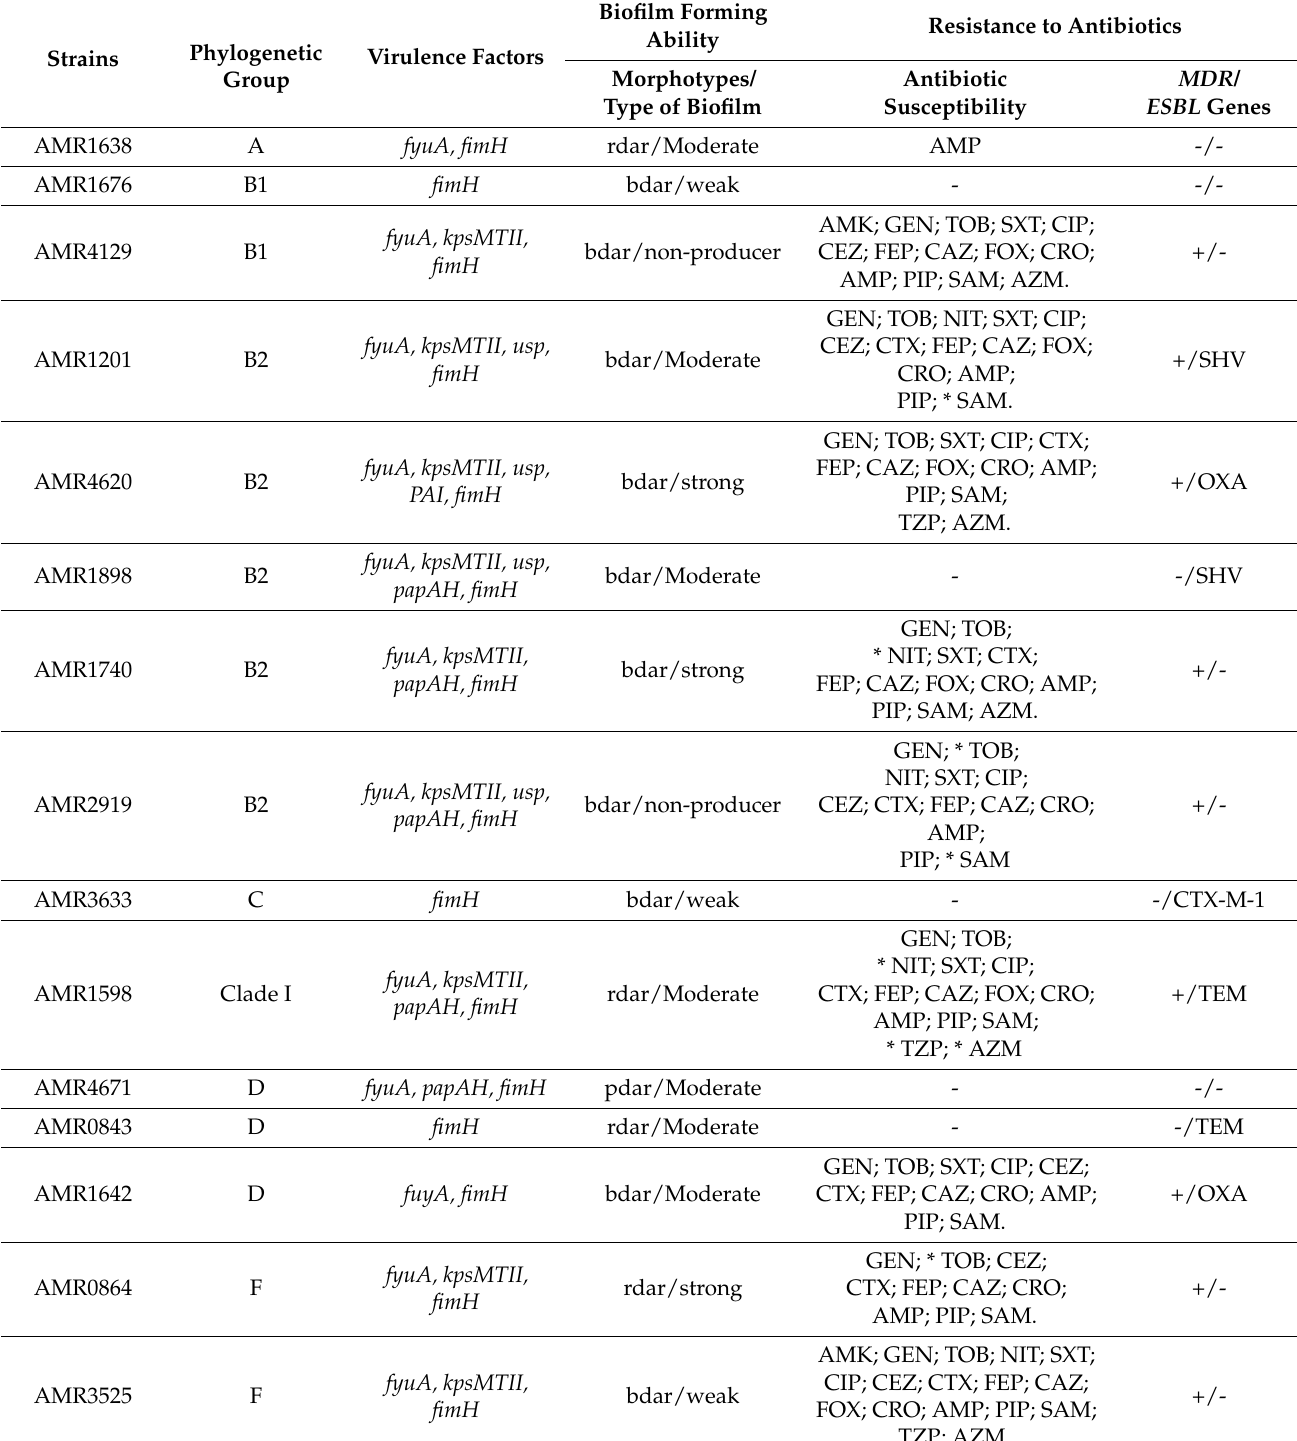
Table 3. Genotypic characteristics, virulence factors, resistance to antibiotics, and production of ESBL of UPEC selected.